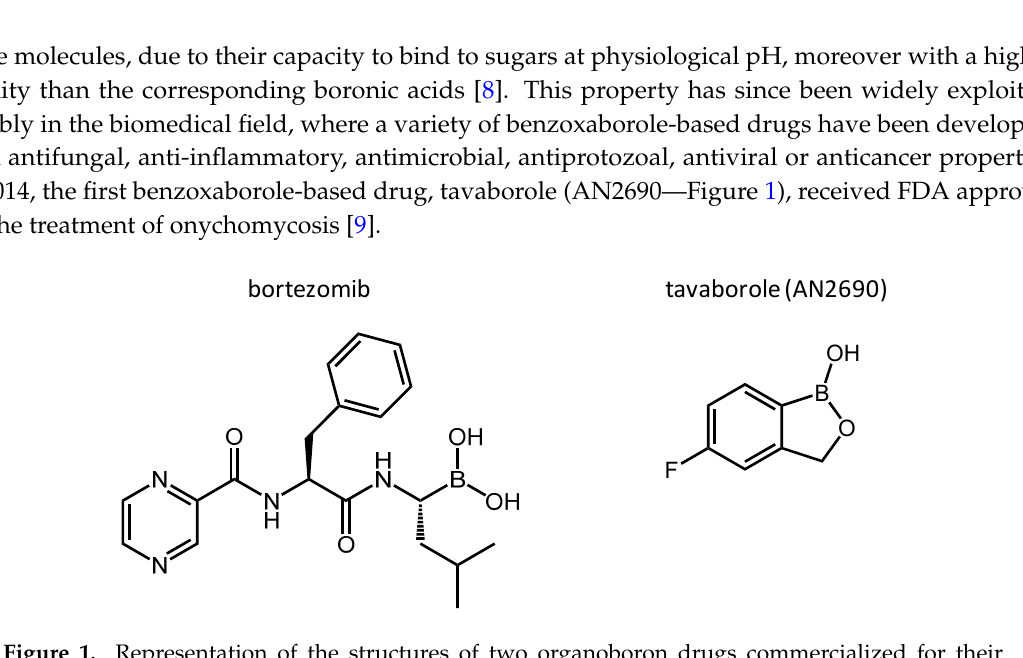
Figure 1. Representation of the structures of two organoboron drugs commercialized for their anti-cancer ( left ) and antifungal ( right ) properties.